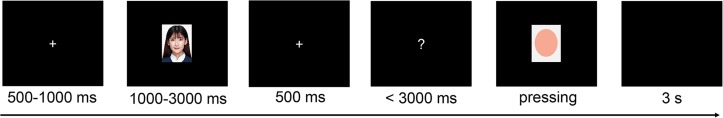
Schematic illustration of the temporal reproduction task.